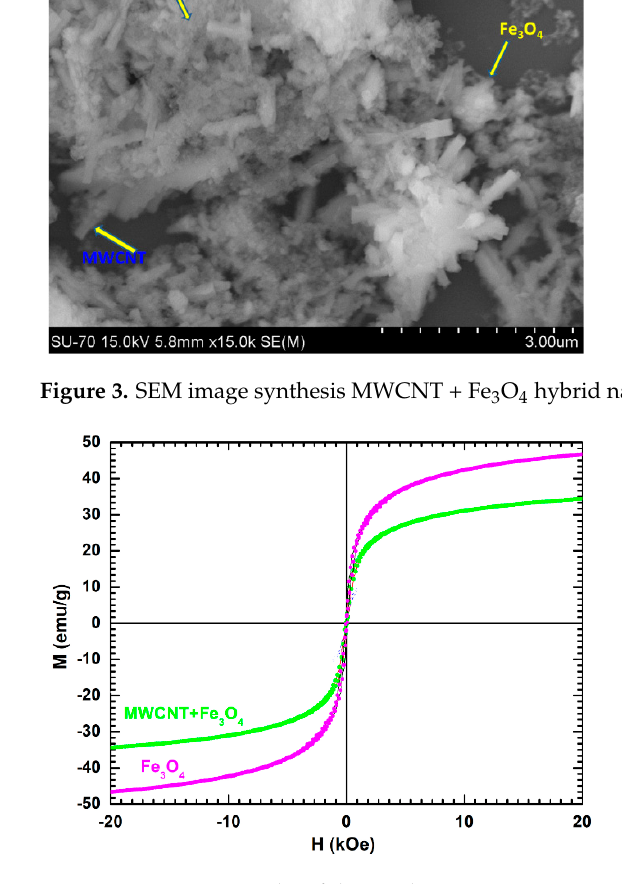
Figure 3. SEM image synthesis MWCNT + Fe 3 O 4 hybrid nanoparticles.